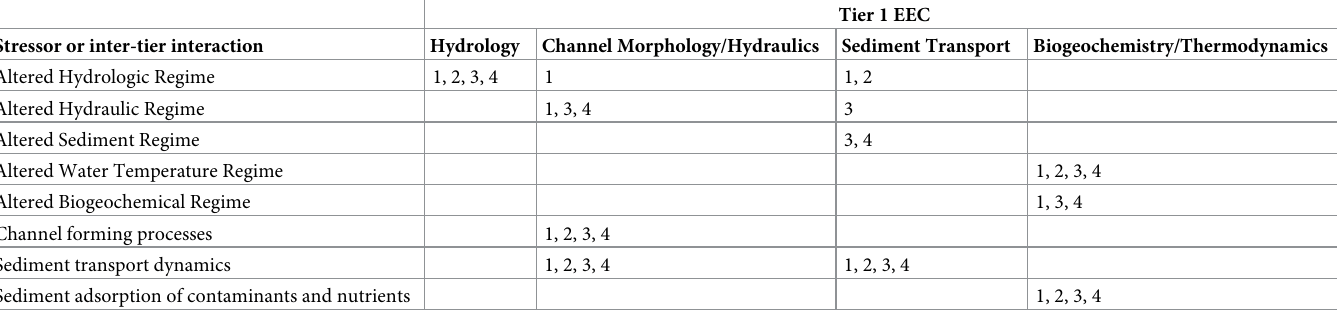
Table 1. Stressors or inter-tier interactions affecting Tier 1 Essential Ecosystem Characteristics (EEC) identified as an information need in the application of the conceptual model to case studies in the Canadian River (1), Colorado River (2), Columbia River (3), and Upper Mississippi and Illinois rivers (4). Tier 1